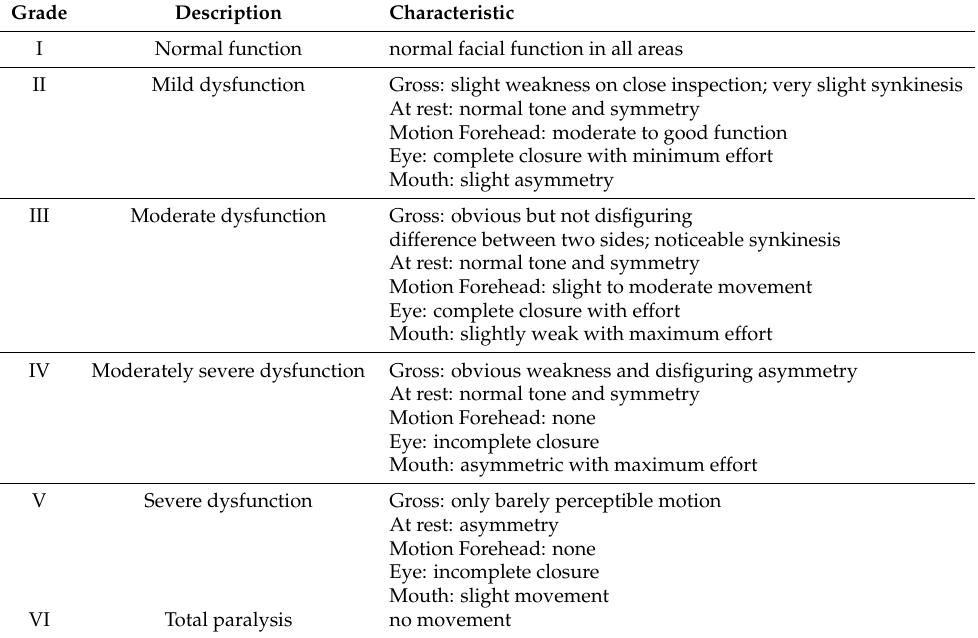
Table 1. House–Brackmann scale